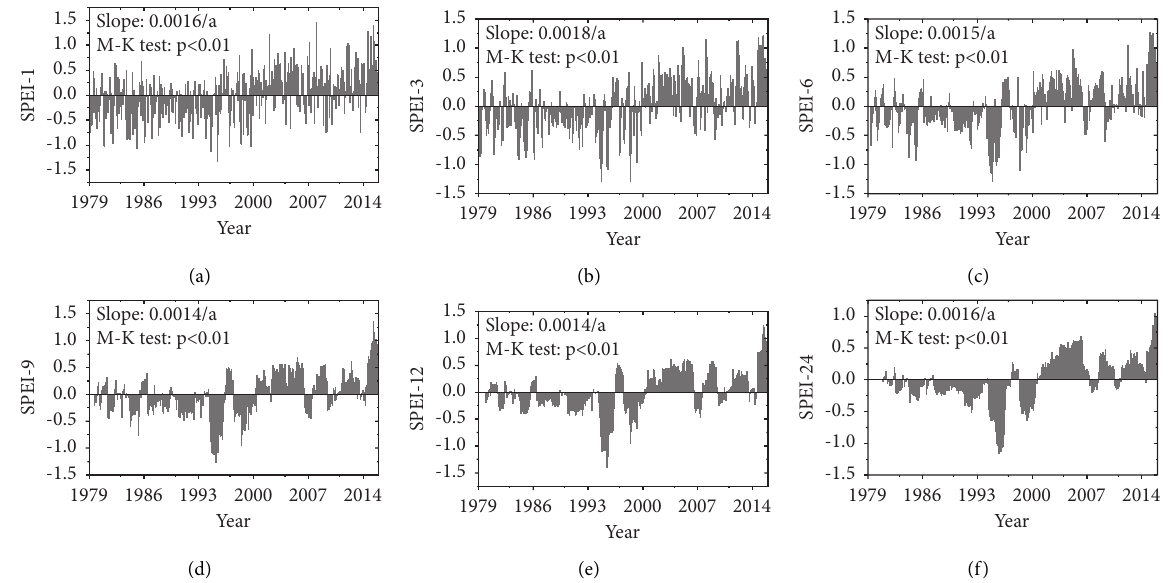
Figure 3: Temporal variability of the SPEI values at 1-, 3-, 6-, 9-, 12-, and 24-month time scales for the period 1979–2015 in the